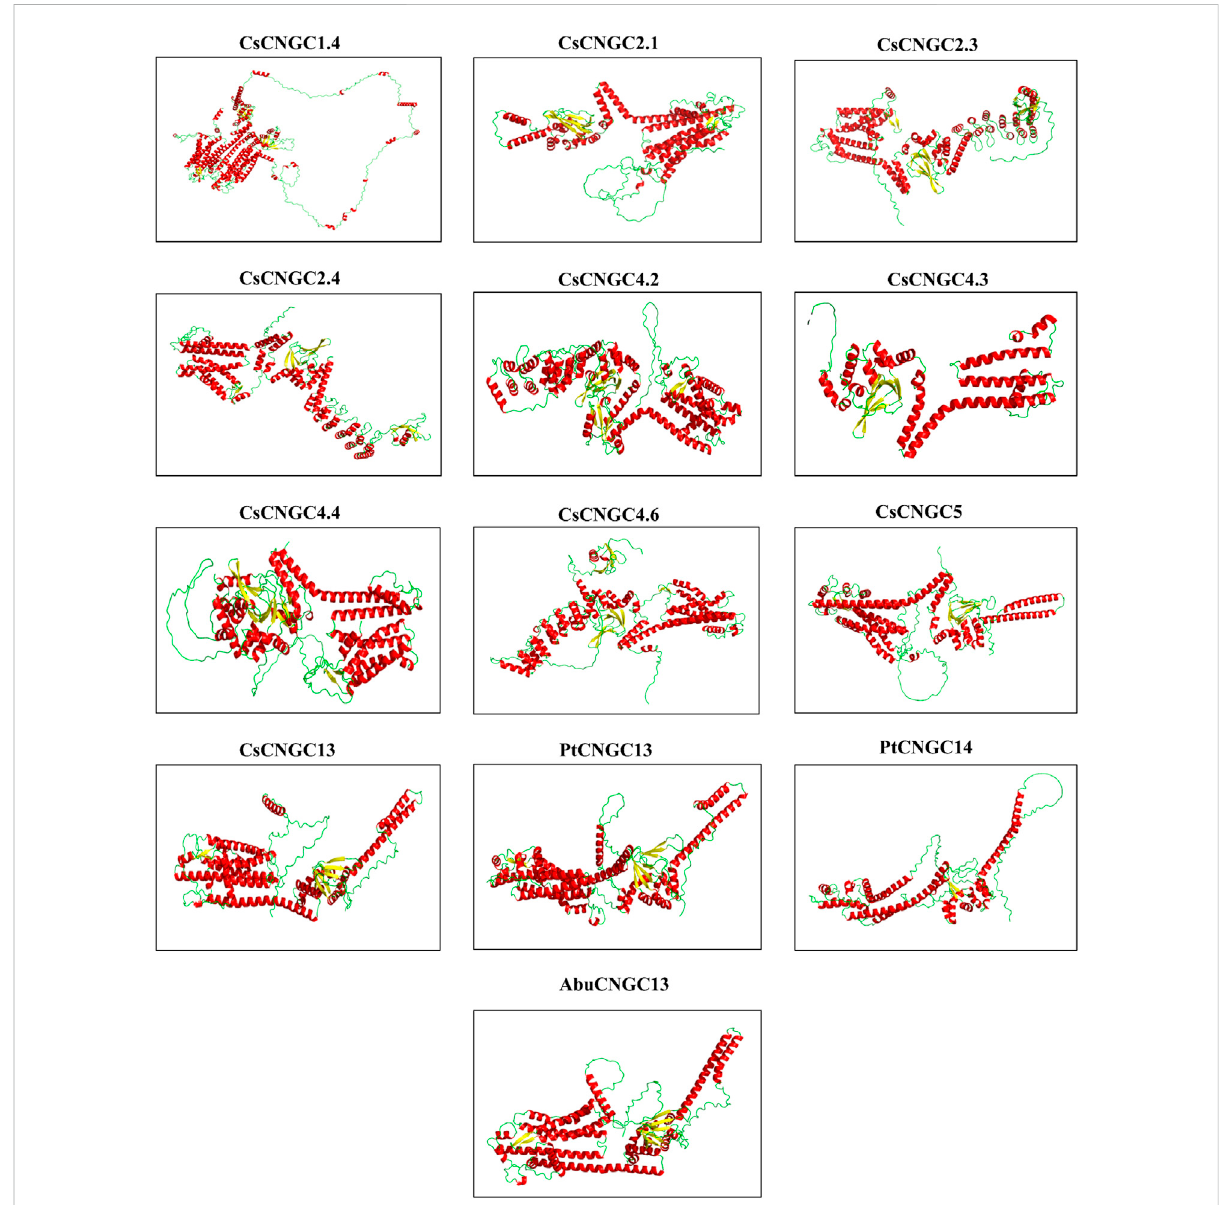
FIGURE 10 Predicted 3D structures of 12 CNGCs in C. sinensis, A. buxfolia, and P. trifoliata using Alphafold2. CsCNGC1.4 has been predicted by using tRrosetta. Structures are displayed based on secondary structures. Spirals with red color represent alpha helices, wide arrows with yellow color represent beta sheets, and wires with green color represent the